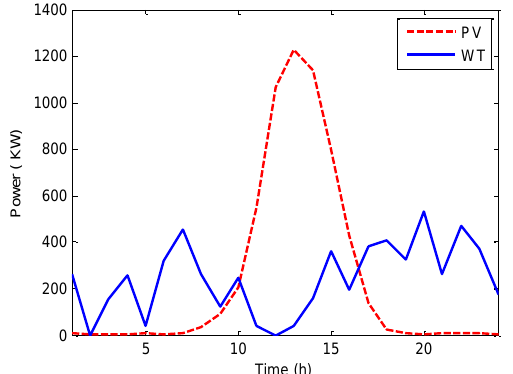
Figure 19. Reactive power losses for 24 h (second scenario).